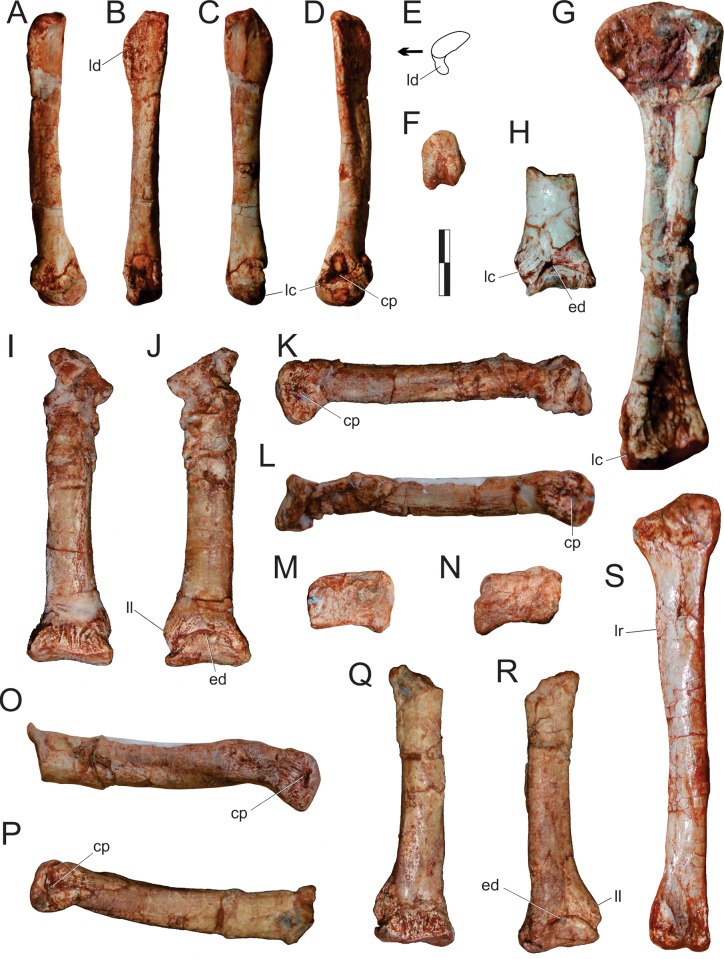
Pampadromaeus barberenai (ULBRA-PVT016), metatarsus.Photographs (A-D,F) and drawing (E) of the metatarsus. Left metatarsal I in (A) medial, (B) caudal, (C) cranial, (D) lateral, (E) proximal (arrow points cranially), and (F) distal views. Left metatarsal II in (G) caudal view. Distal portions of right metatarsal II in (H) dorsal view; right metatarsal III in (I) ventral, (J) dorsal, (K) medial, (L) lateral, and (M) distal views; left metatarsal III in (N) distal, (O) medial, (P) lateral, (Q) ventral, and (R) dorsal views. Right metatarsal IV in medial (S) view. Abbreviations: cp, collateral ligament pit; ed, extensor depressions; lc lateral condyle; ld, lateral deflection; ll, lateral lip; lr, longitudinal rugose ridge. Scale bar = 1 cm.